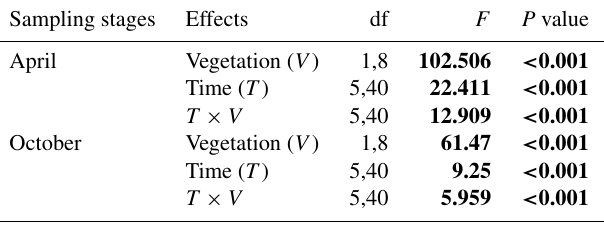
Table A1. Repeated ANOVA measurements for the effects of vegetation (riparian areas with vegetation vs. without vegetation; between-subject factor) and time (measuring times in 1d; within- subject factor) on the CO 2 fluxes in two sampling stages (April and October) in riparian areas. Degree of freedom (df) and F and P (significance) values are given.